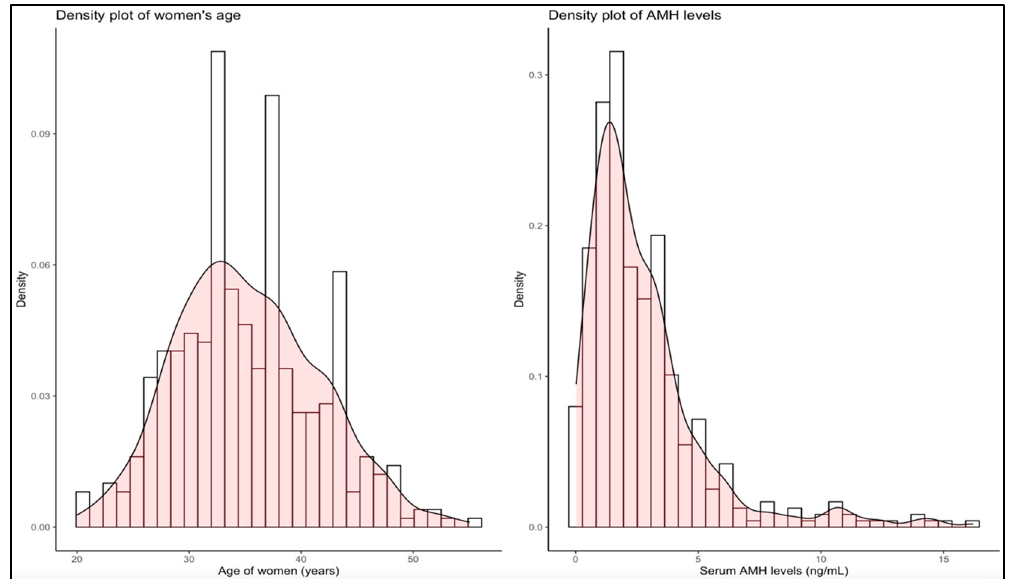
Figure 1. Density plot of women’s age and AMH levels.